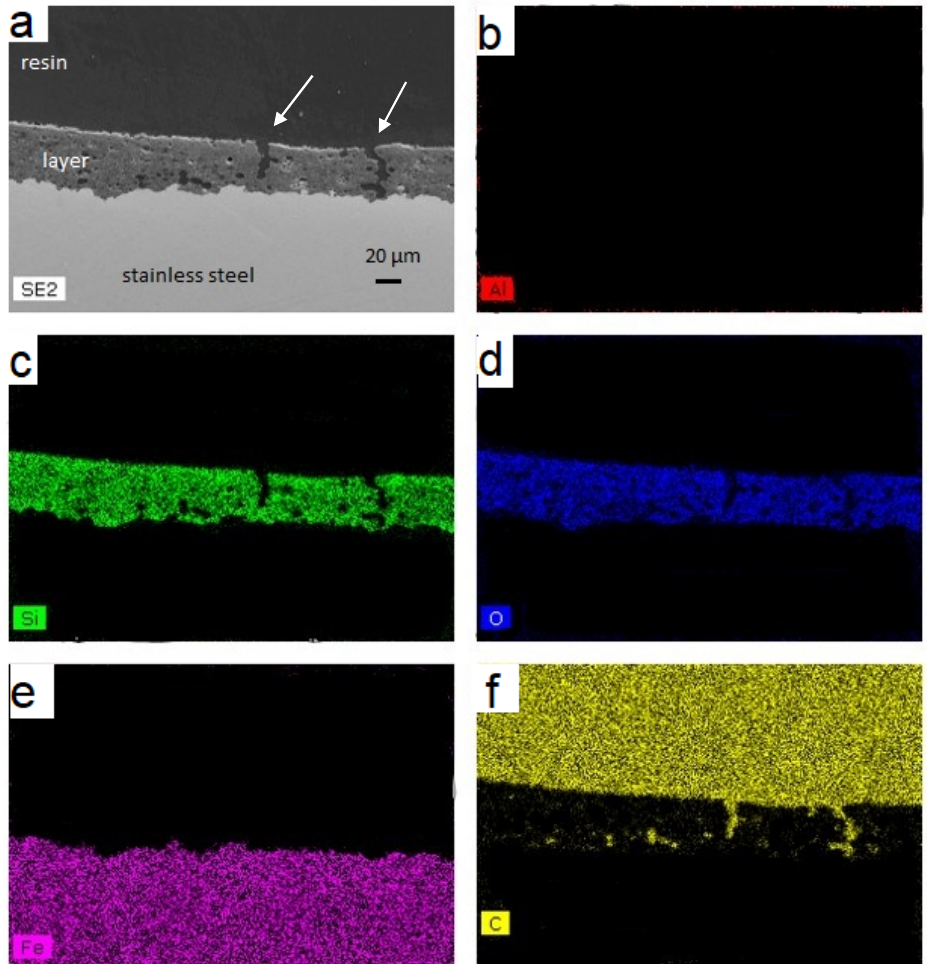
Figure 10. ( a ) SEM image of the protective layer on the 304 L tube after aging during 600 h at 700 °C in liquid AlSi 12 (300 X magnification) and EDS analysis of Al ( b ), Si ( c ), O (d), Fe ( e ), and C ( f ).